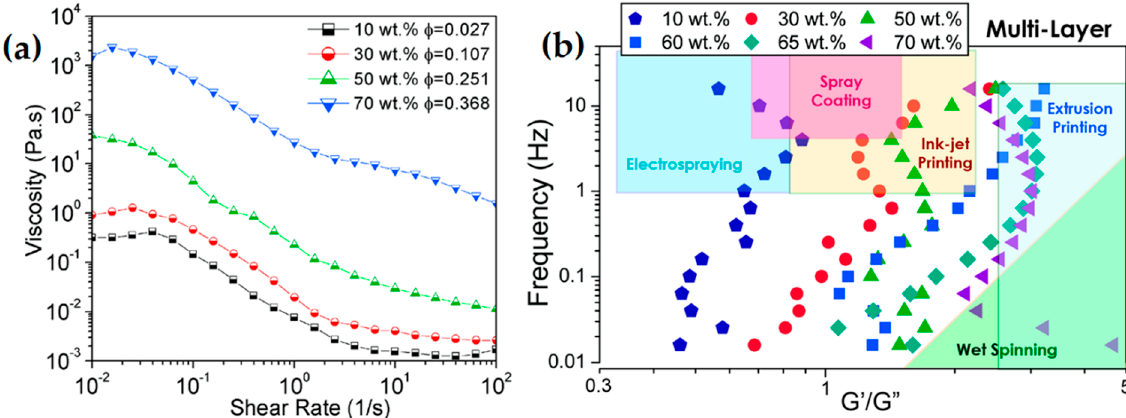
Figure 7. ( a ) Measured viscosity versus the shear rate of multi − layer MXene flake suspension ( b ) Frequency dependence of the ratio of the G ′ elastic modulus to G ″ viscous modulus for multi-layer Ti 3 C 2 T x MXene flakes dispersed in water, reprinted with permission from [87] .